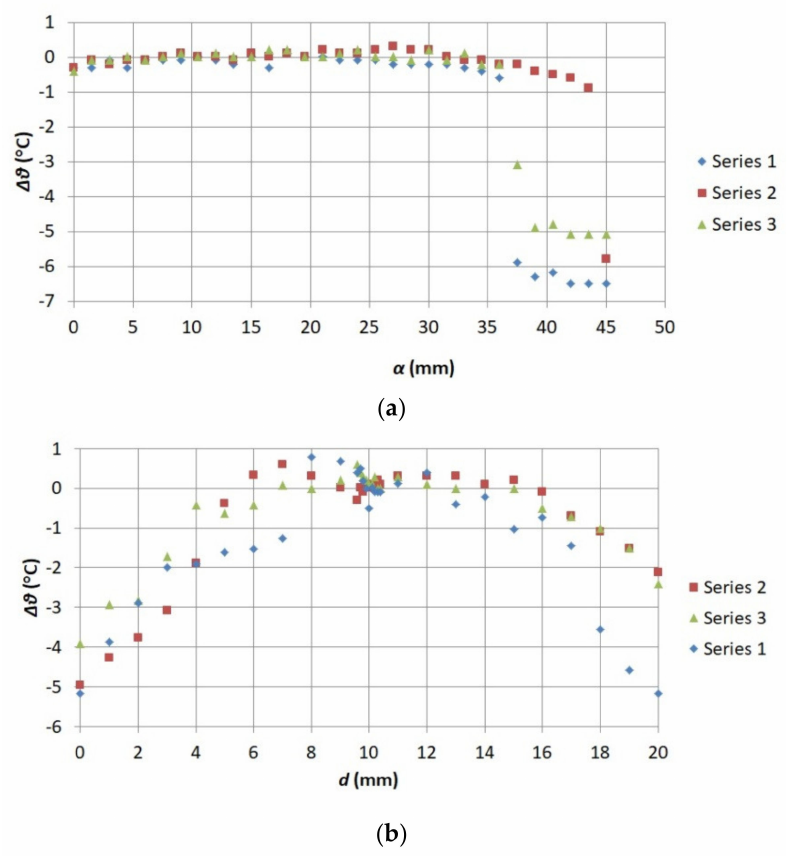
Figure 12. Relationship between the absolute error value of the thermographic temperature and ( a ) focus adjustment ring angle on the thermographic camera lens α , ( b ) distance between the lens and the observed object d